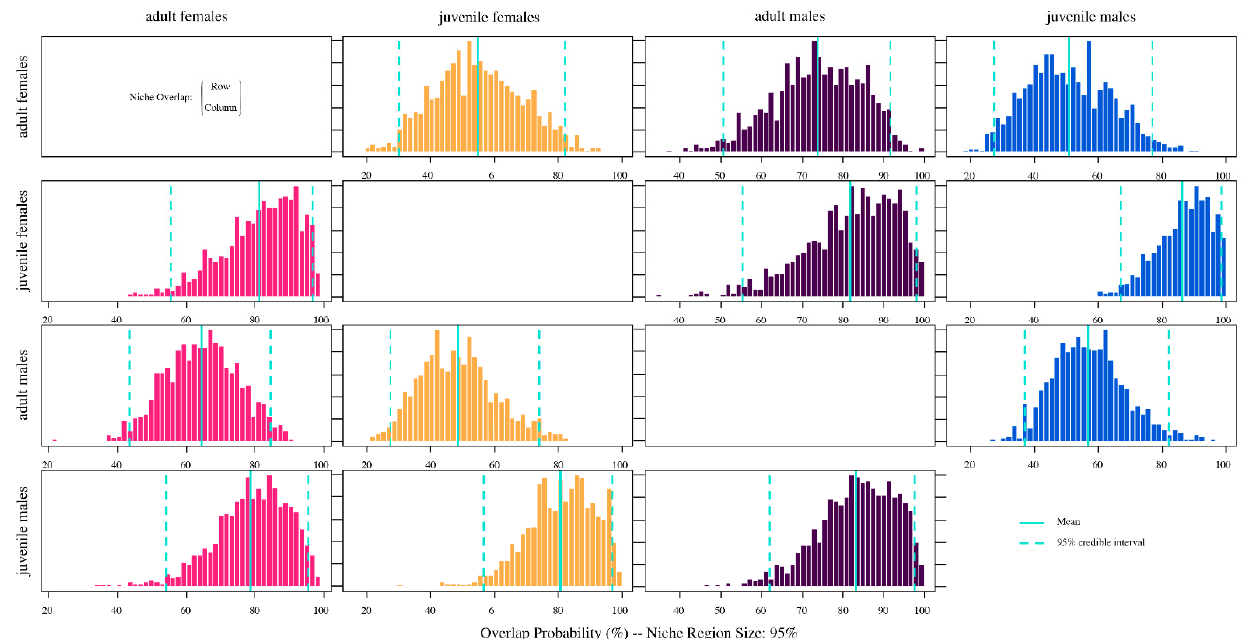
Figure 6. Bayesian plot of the posterior probability distribution of niche region metric (%) for the southern king crab Lithodes santolla groups estimated by nicheROVER analysis. The posterior means and 95% credible intervals are displayed in turquoise color. and 95% credible intervals are displayed in turquoise